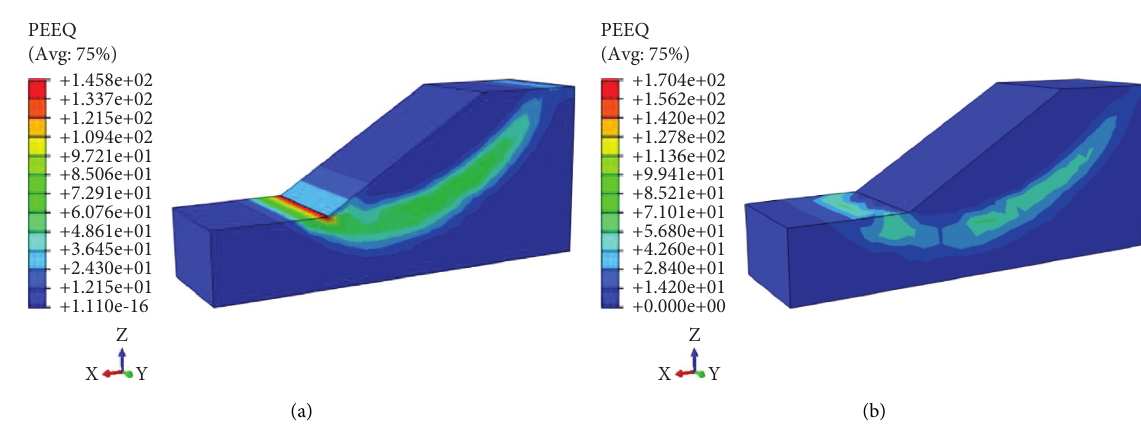
Figure 13: Equivalent plastic stress cloud diagram when an unprotected slope fails. (a) Before slope protection; (b) after planting Figure 12 is a cloud diagram of the slope displacement.